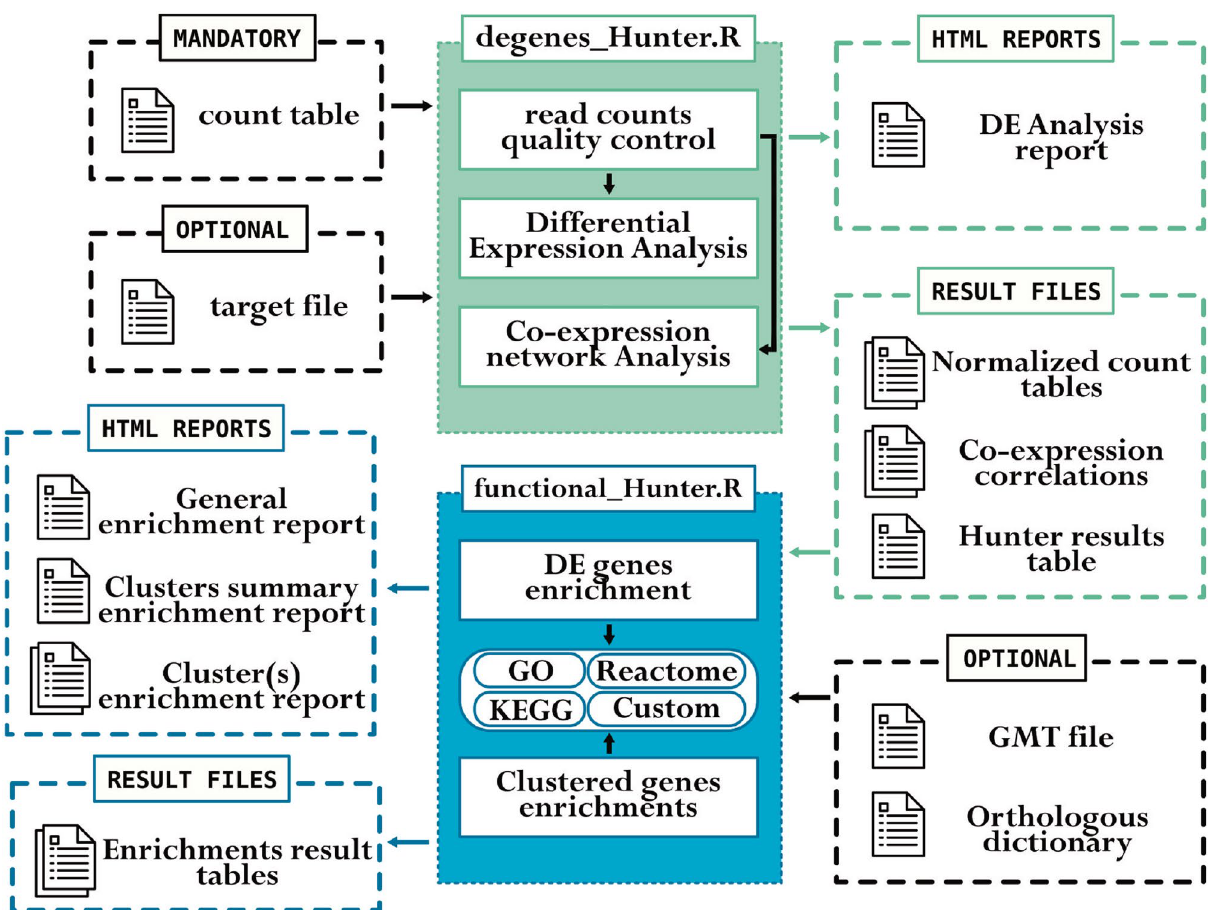
Figure 1. Overview of the workflows implemented in ExpHunter Suite and their input/output. The green box represents the DEgenes Hunter module related to differential expression analysis; the blue box represents the functional Hunter module related to functional enrichment analysis. Boxes with dashed borders represent input and output files, including html